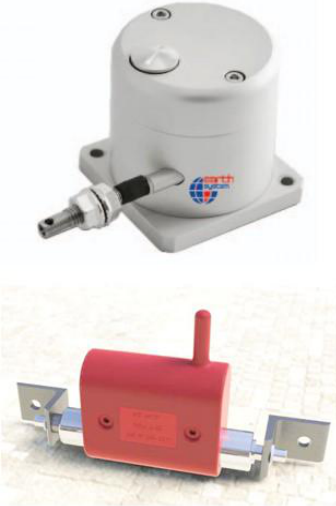
Figure 3. Examples of electronic linear motion sensors